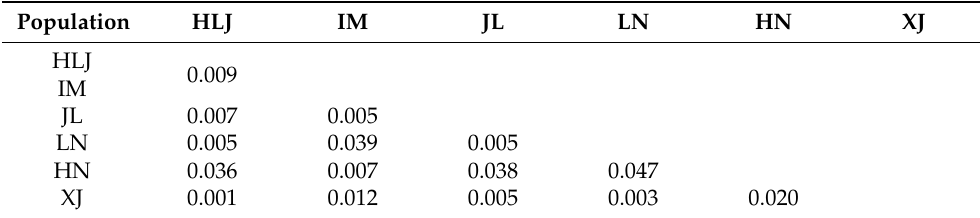
Table 5. Estimates of genetic differentiation (Fst) over sequence pairs and between geographi- cal populations.